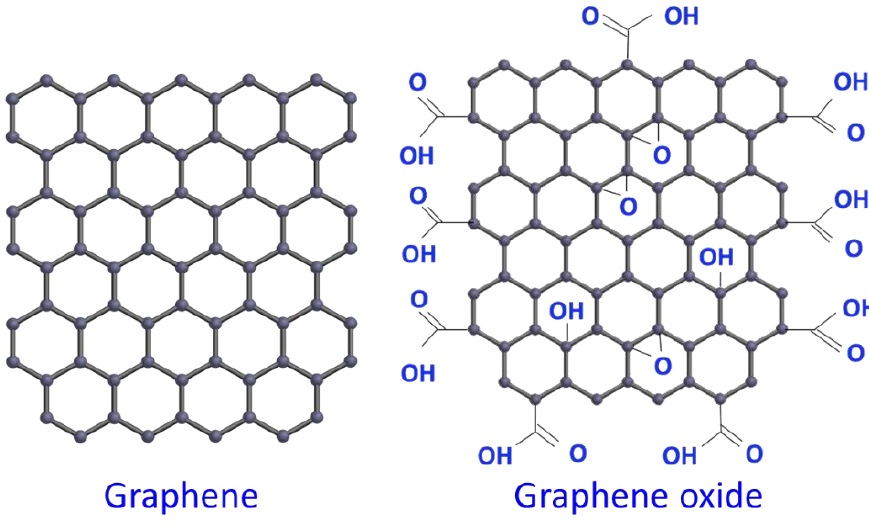
Figure 2. Graphene and graphene oxide. 4. Polymer/Graphene Nanofibers for Nanocomposite Membranes